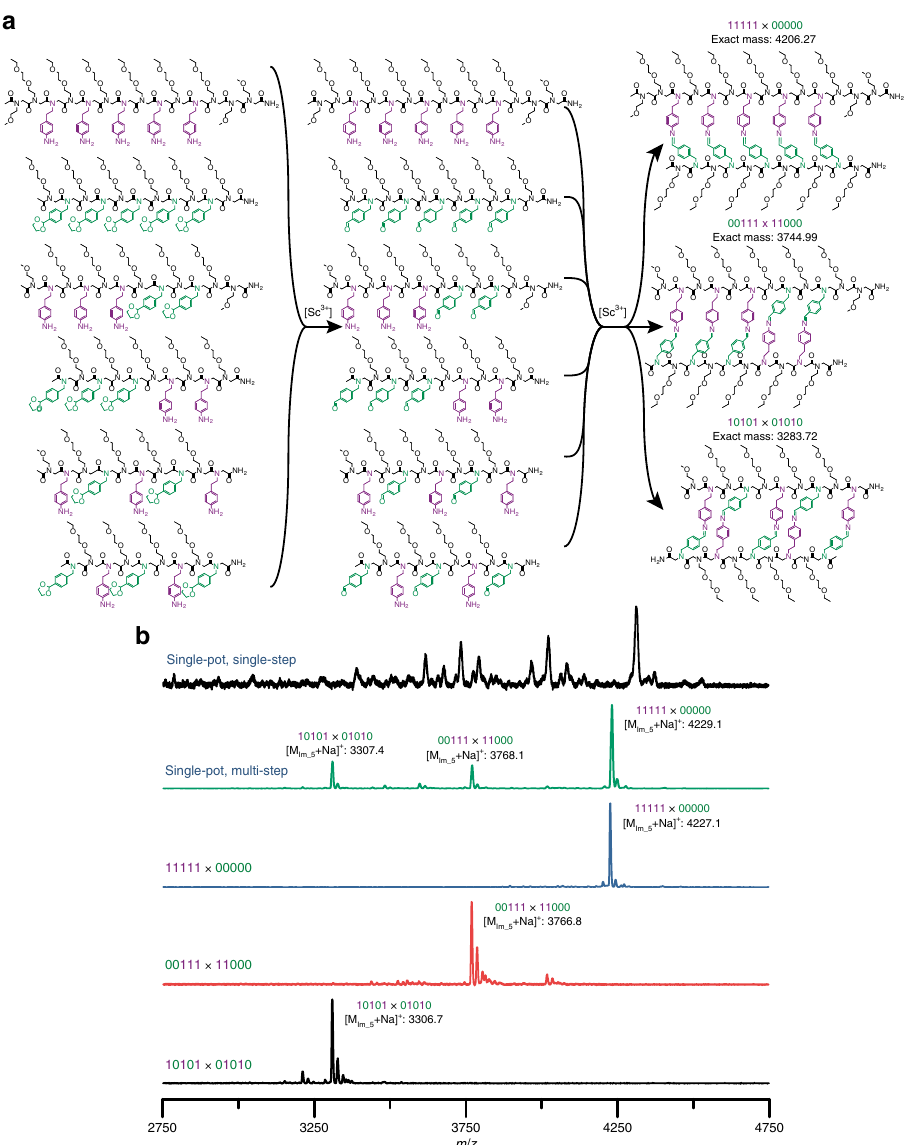
Fig. 3 Sequence-selective hybridization. a Structures of mass-labeled, ethylene acetal-protected precursor peptoid sequences, deprotected, dissociated sequences upon treatment with Sc(OTf) 3 , and in-registry molecular ladders upon [Sc 3 + ] extraction and annealing. b MALDI mass spectra of individual encoded molecular ladders assembled via the dissociation/extraction/annealing process, including 10101×01010 (bottom, black), 00111×11000 (second from bottom, red), 11111×00000 (middle, blue), and a single-pot solution of all six oligomers to yield three in-registry molecular ladders (second from top, green). A single- pot solution of the six oligomers after the single-step, deprotection and direct assembly process (top, black) is shown for comparison. Expected exact masses: [M 10101×01010 + Na] + = 3306.71; [M 00111×11000 + Na] + = 3767.93; [M 11111×00000 + Na] + = 4229.25. Peaks at multiples of + 18 m / z values are attributable to ladders species with fewer